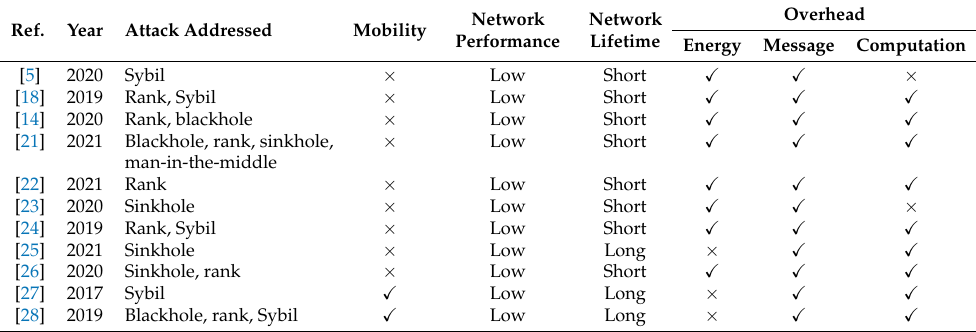
Table 1. Comparison of the previously published studies in the state-of-the-art. Ref. Year Attack